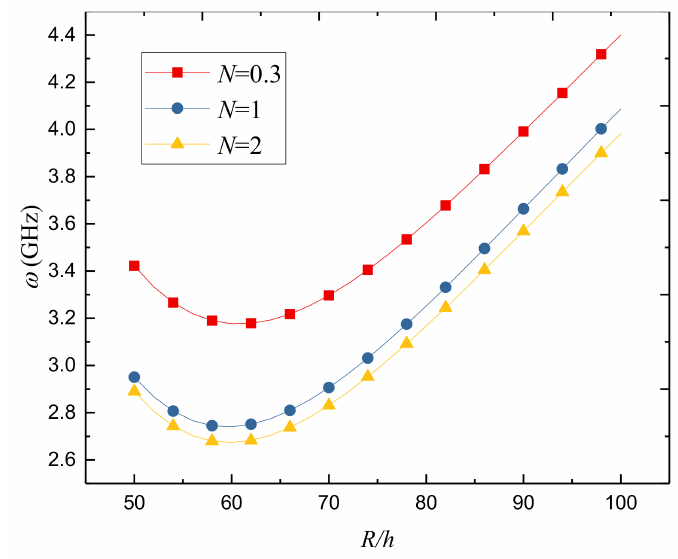
Figure 4. Variation of the natural frequency ω (GHz) against the radius-to-thickness ratio for